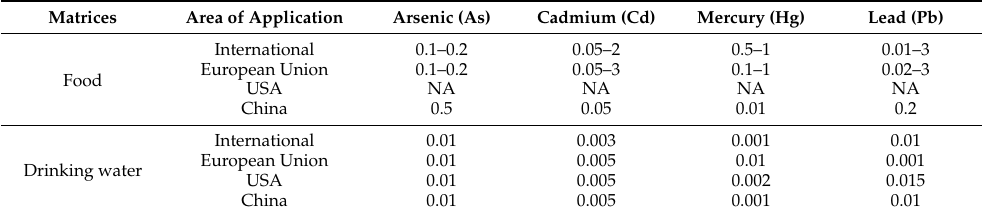
Table 1. Permissible limits (ppm) for heavy metals in food and drinking water according to inter- national and local standards. Note that the US Food and Drug Administration has not established regulatory limits for trace metals in finished food products other than bottled